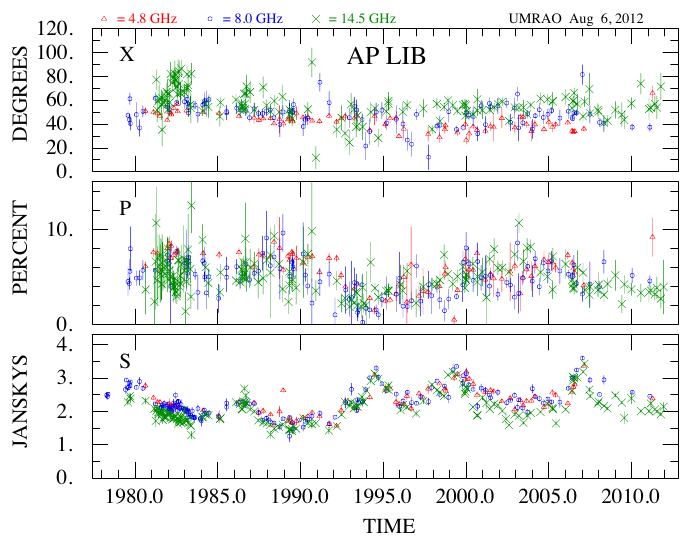
Figure 2. From bottom to top: Long-term total flux density (S), fractional linear polarization (P%), and EVPA for AP Librae. Two-week-averaged data are shown. No rotation measure was determined for this source in [10]: the fractional polarization was weak (0.7%) during the MOJAVE epoch analyzed, 28 April 2006.